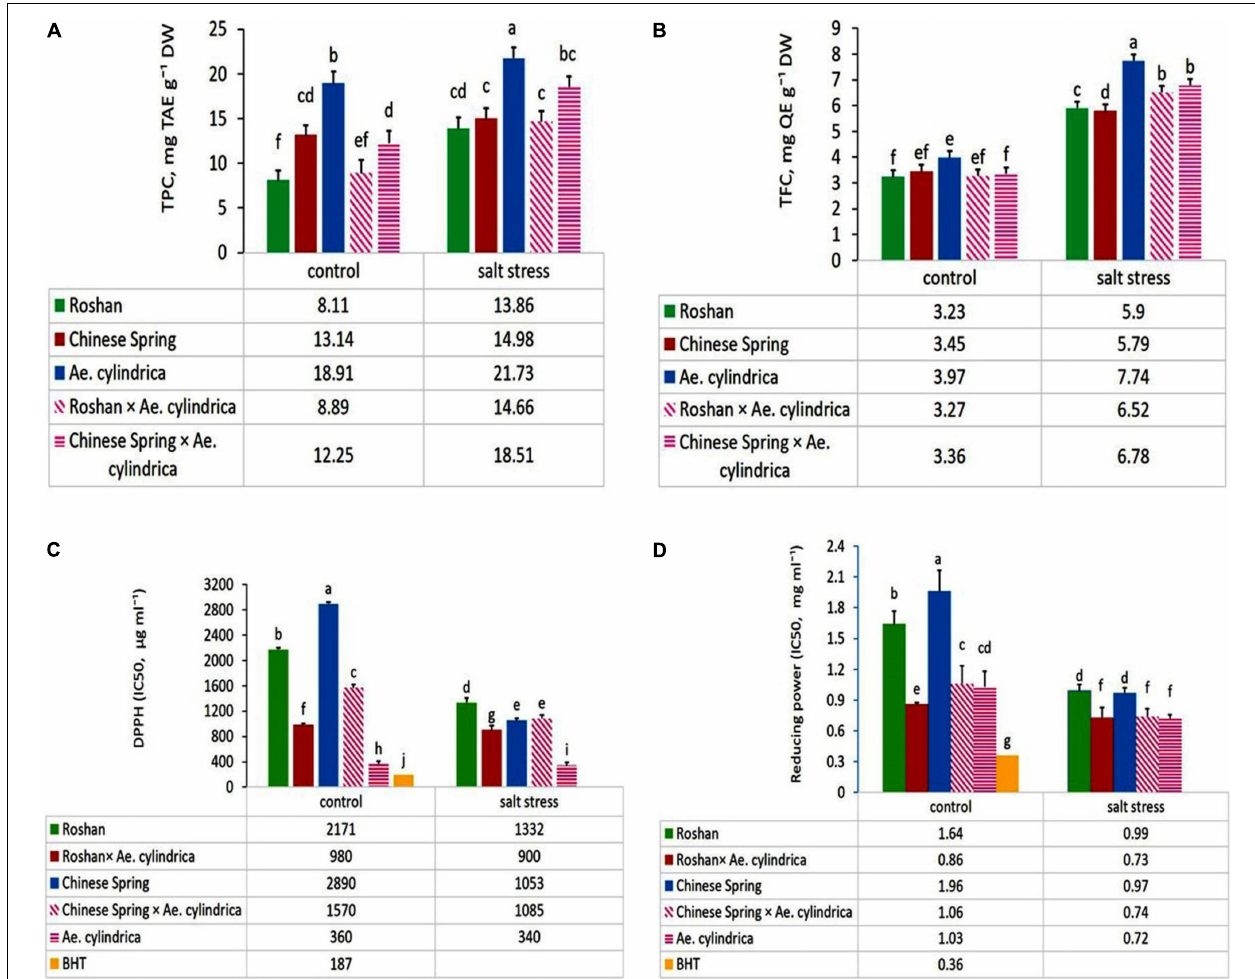
FIGURE 2 | Mean comparison of (A) total phenolic contents (TPC, mg TAE g − 1 DW), (B) total flavonoid content (TFC, mg QE g − 1 DW), (C) DPPH (IC50, µ g ml − 1 ), and (D) reducing power (IC50, mg ml − 1 ) of parents ( T. aestivum “Roshan,” “Chinese spring,” Ae. cylindrica ) and their F 1 hybrid plants (amphidiploids) under control and salt stress conditions. Bars represent means ± SE and bars with the same letter do not significantly differ at p < 0.05 among the